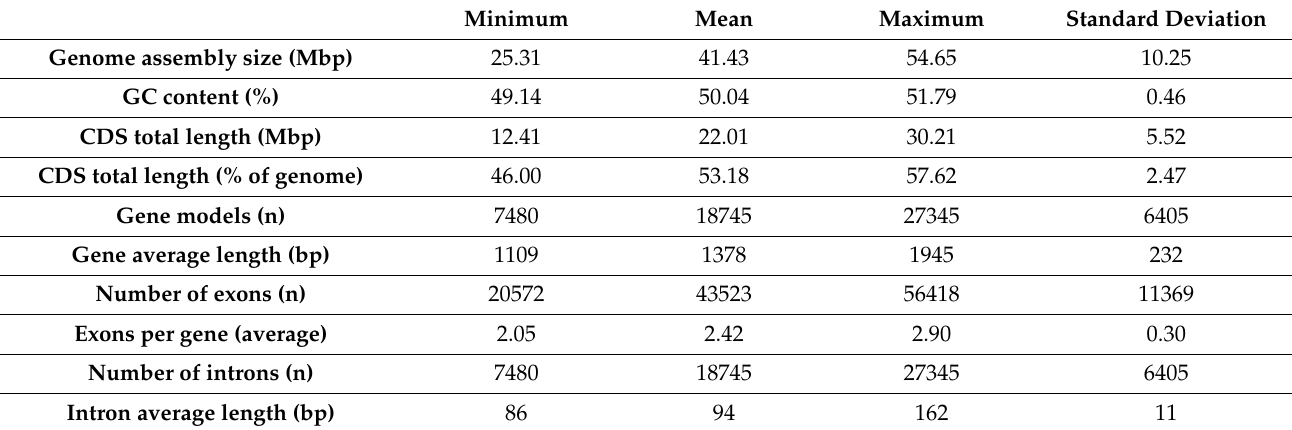
Table 3. Statistics for the sequenced A. melanogenum